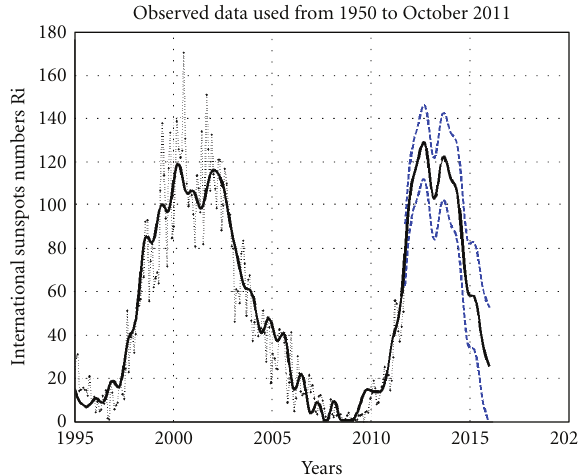
Figure 6: SC24 shape prediction for cosmic ray monthly index variation. Dotted line demonstrates the real data. Dashes show the one sigma intervals. Solid is the modeled curve.